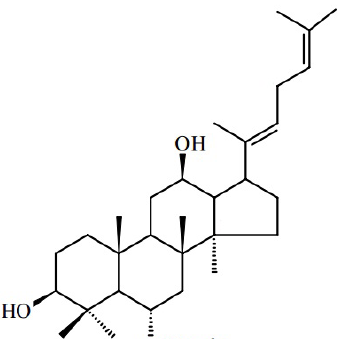
Figure 1. Chemical structure of